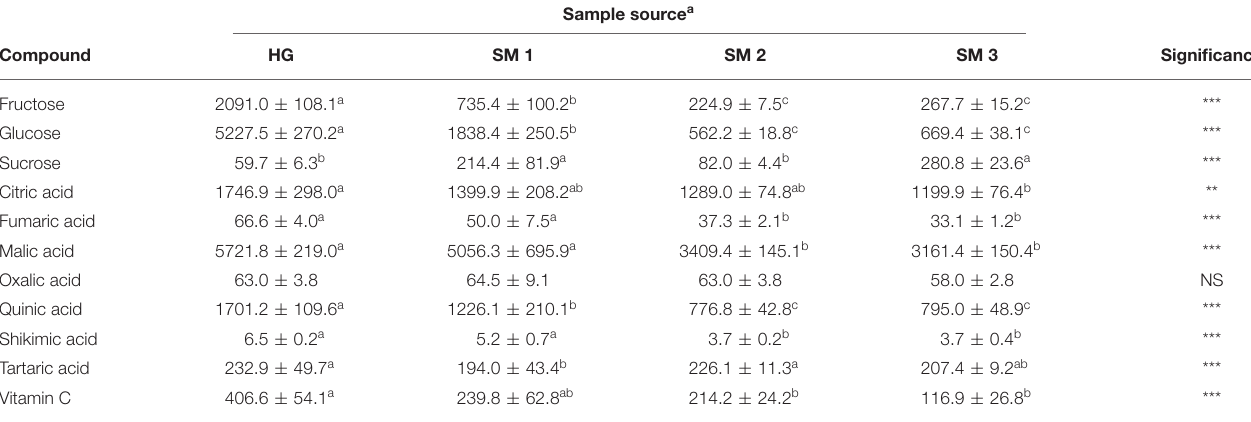
TABLE 1 | Individual sugars, organic acids, and vitamin C levels (mg kg − 1 FW ± SE) of different V. locusta “Vit” samples prior to refrigerated storage (T0). Sample source